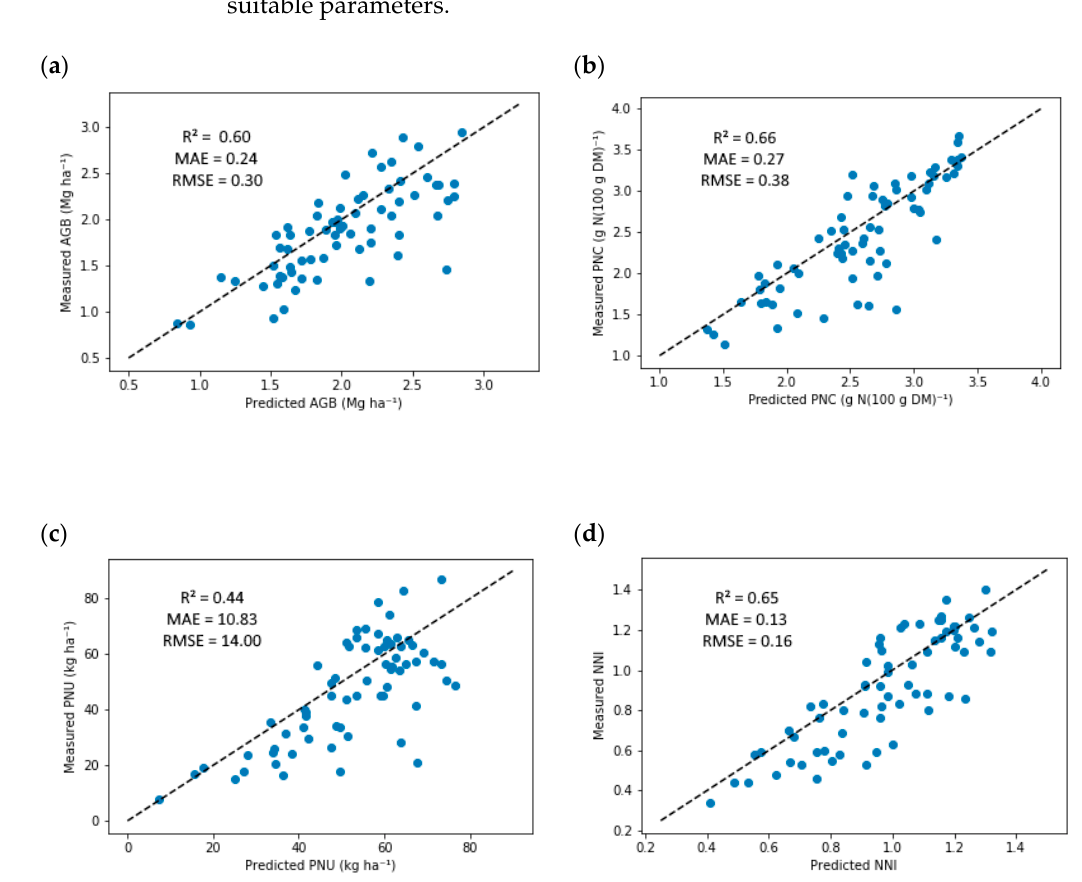
Figure 6. Measured versus predicted ( a ) aboveground biomass (AGB), ( b ) plant N concentration (PNC), ( c ) plant nitrogen uptake (PNU), and ( d ) nitrogen nutrition index (NNI) by XGB regression models using testing dataset and all phenom metrics and management data. Table 5. XGB cross-validation hyperparameters. Mean absolute error was minimized for ABG, PNC, and NNI using built-in function and was manually tuned for